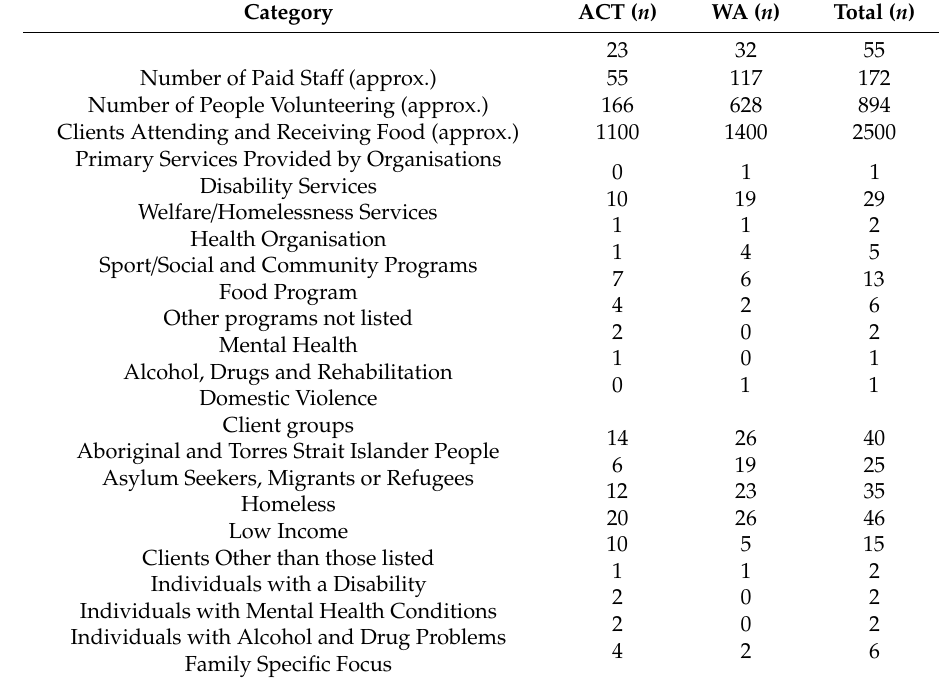
Table 1. Demographic comparison between Western Australia (WA) and Australian Capital Territory (ACT) charitable organizations. Category ACT ( n ) WA ( n ) Total ( n ) 23 32 55 Number of Paid Sta ff (approx.) 55 117 172 Number of People Volunteering (approx.) 166 628 894 Clients Attending and Receiving Food (approx.) 1100 1400 2500 Primary Services Provided by